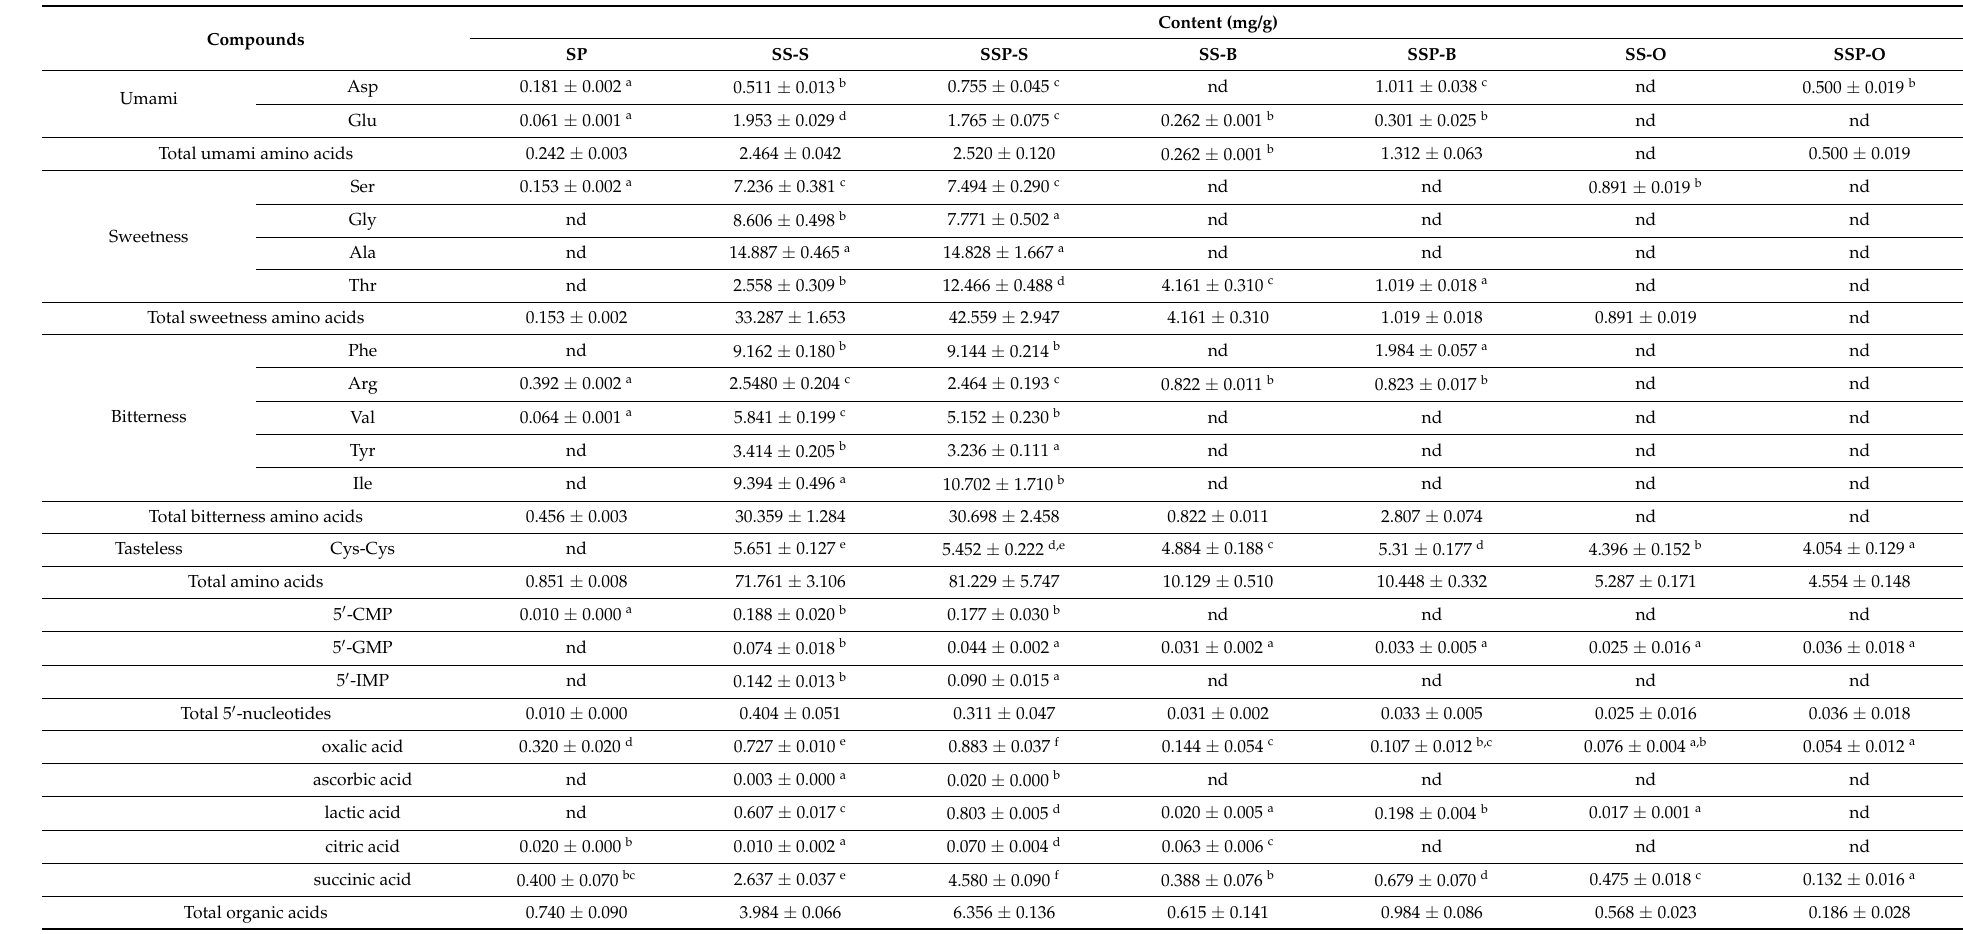
Table 1. The content of free amino acids, 5 (cid:48) -nucleotides and organic acids in stewed sheep tail fat